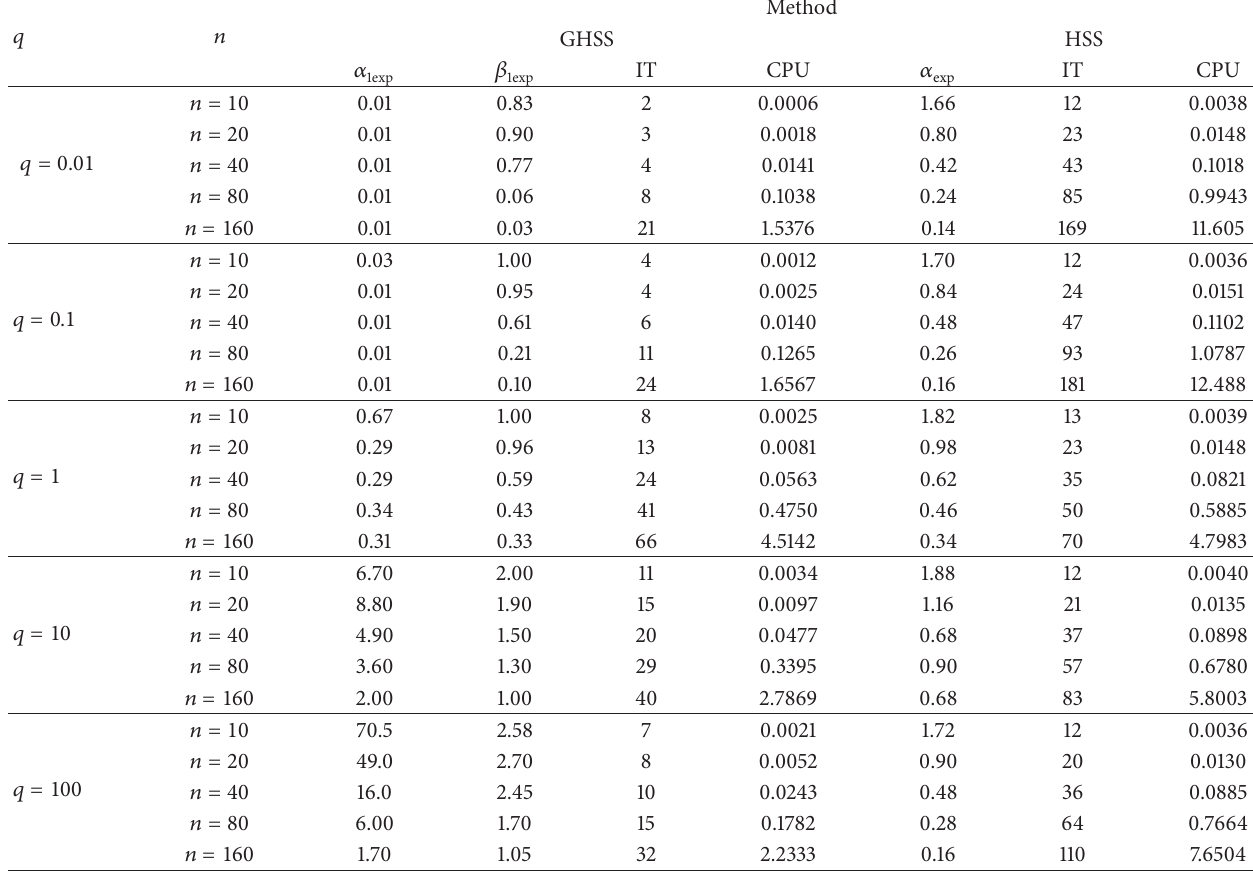
Table 1: Numerical results for GHSS and HSS with the experimental optimal iteration